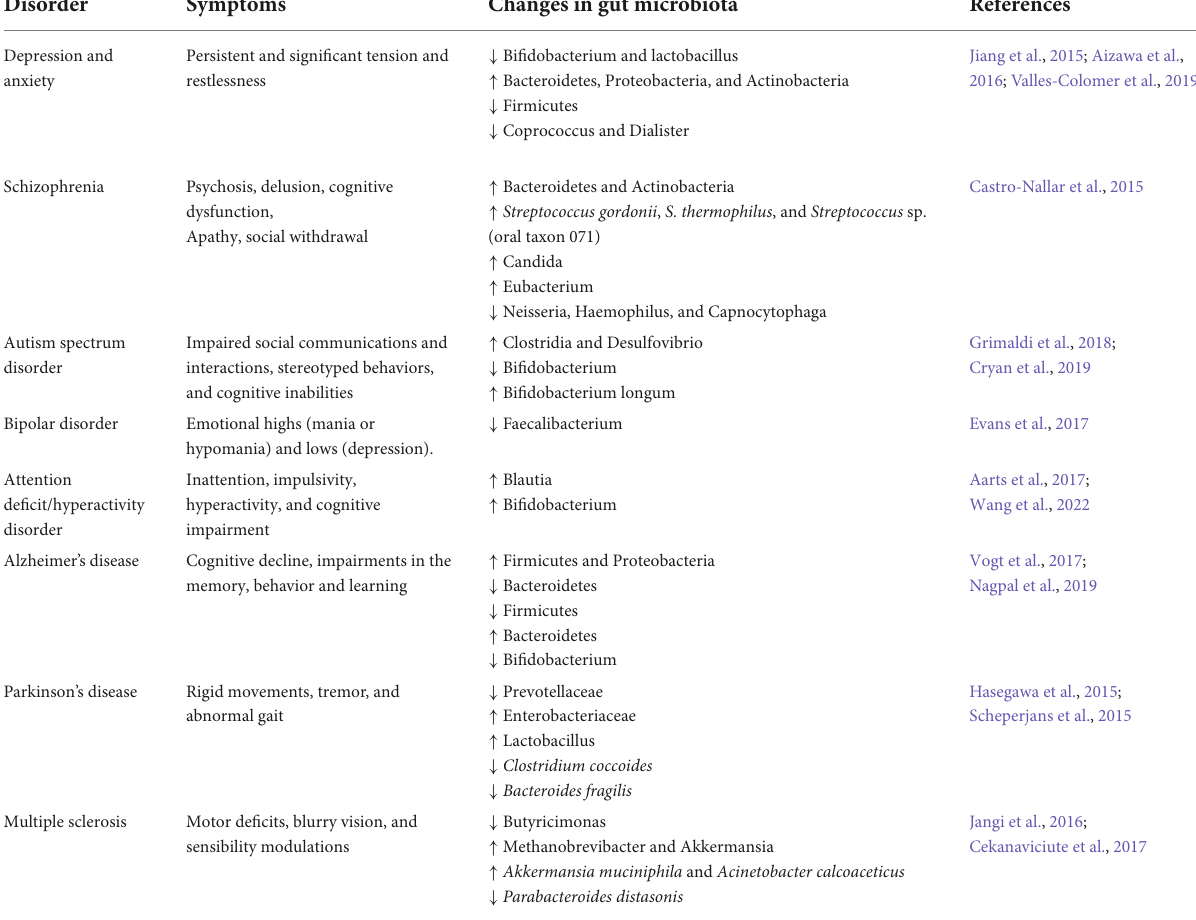
TABLE 1 Changes in gut microbiota in various neuropsychiatric and neurodegenerative